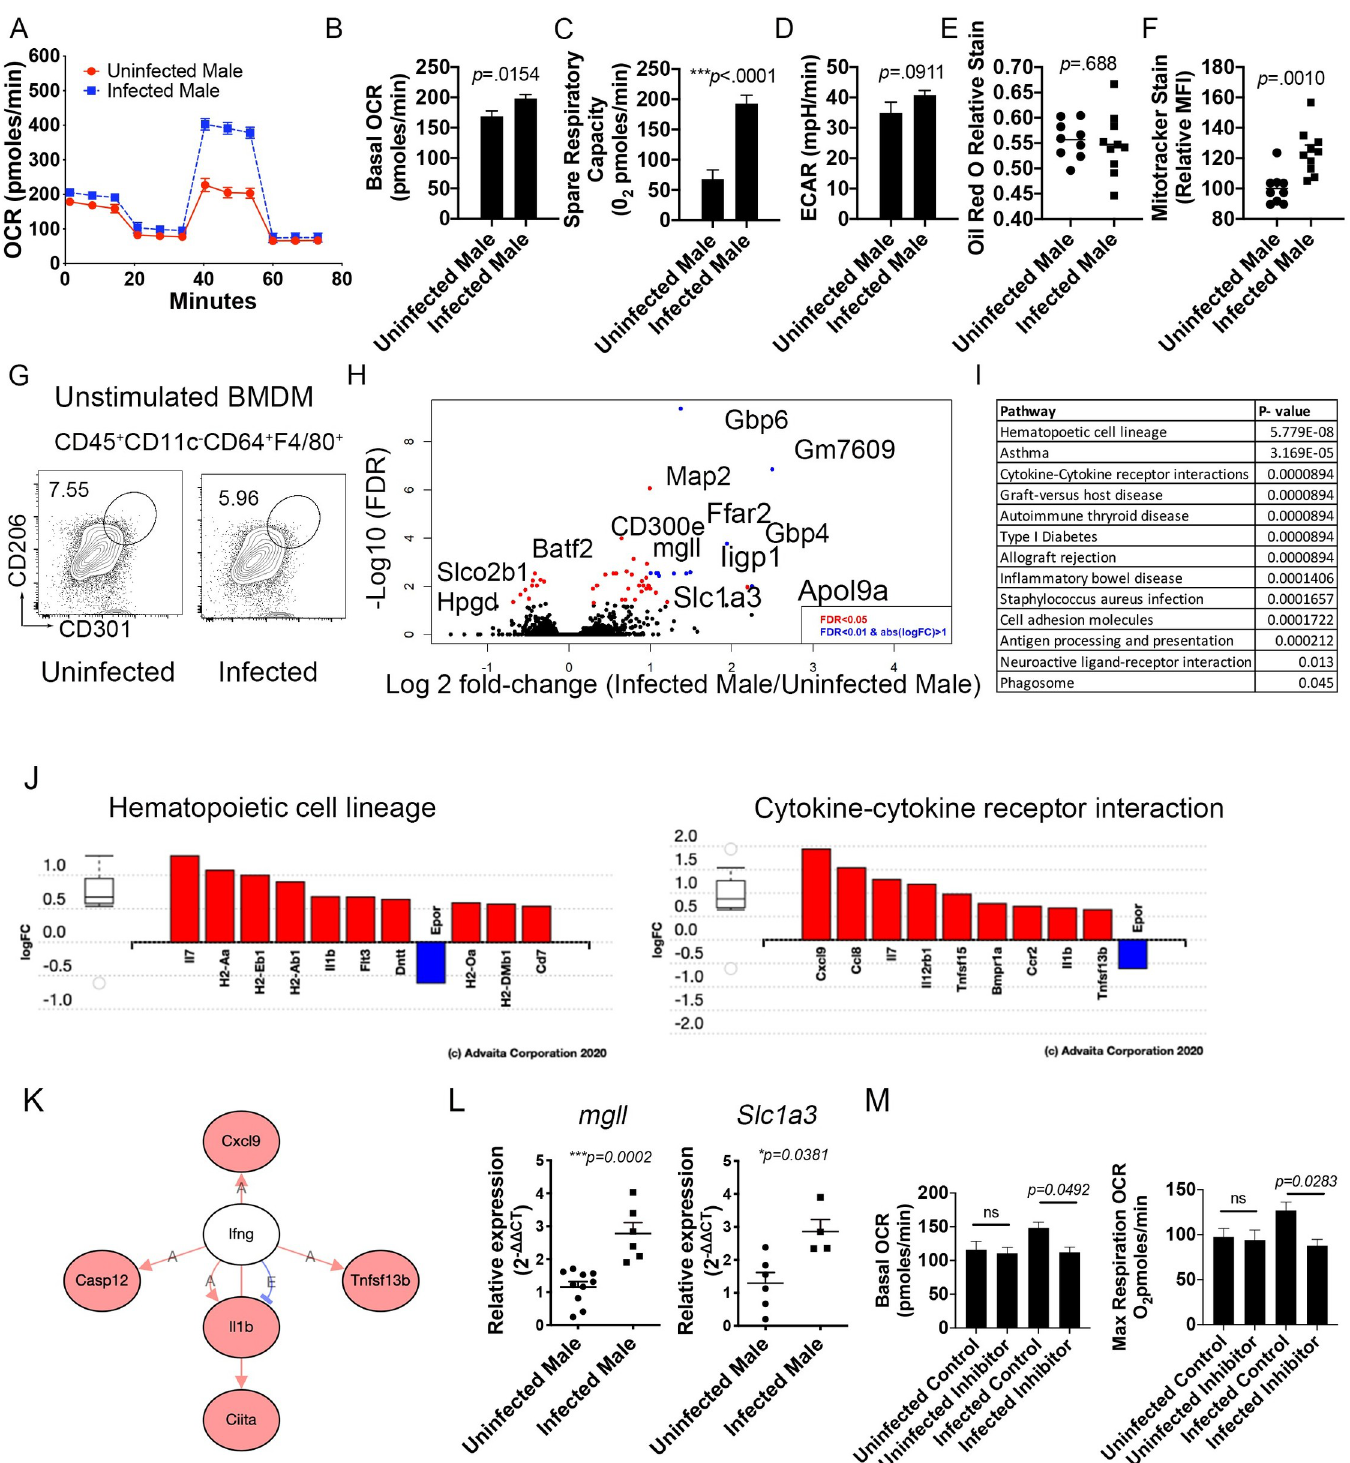
Fig 1. Bone marrow derived macrophages (BMDM) from ApoE -/- male S . mansoni infected mice exhibit increased oxygen consumption and mitochondria mass. ApoE -/- male were fed HFD for 10 days before infection with S . mansoni . Ten weeks post infection mice were sacrificed and bone marrow cells were harvested and cultured under M-CSF. (A) SeaHorse assay results for OCR of BMDM from infected and uninfected ApoE -/- males in basal conditions and in response to mitochondrial inhibitors. (B) Quantification (in picomoles/minute) of the basal oxygen consumption of BMDM. (C) Quantification of the spare respiratory capacity of BMDM (D)